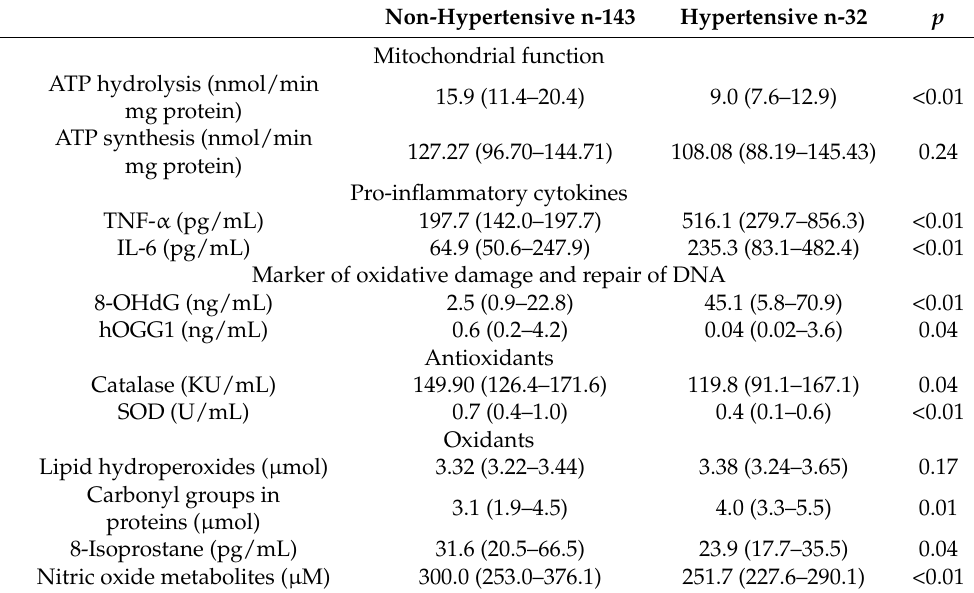
Table 2. Mitochondrial function and oxidative stress markers in hypertensive and non- hypertensive